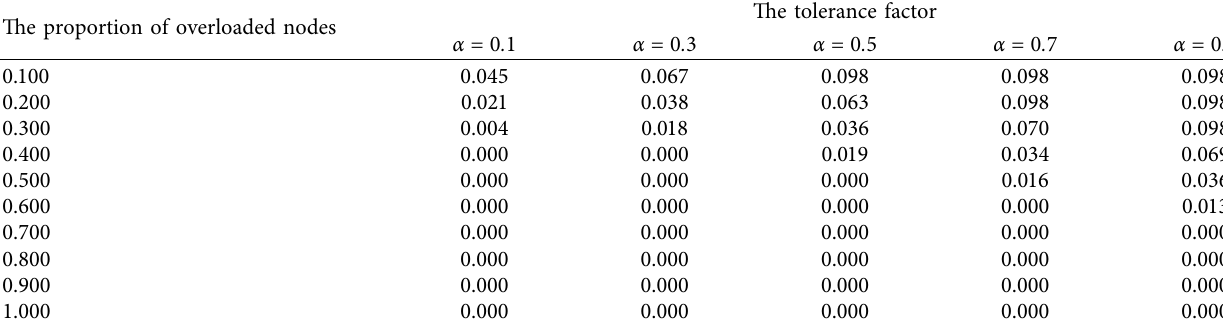
Table 7: Average network efficiency (a).